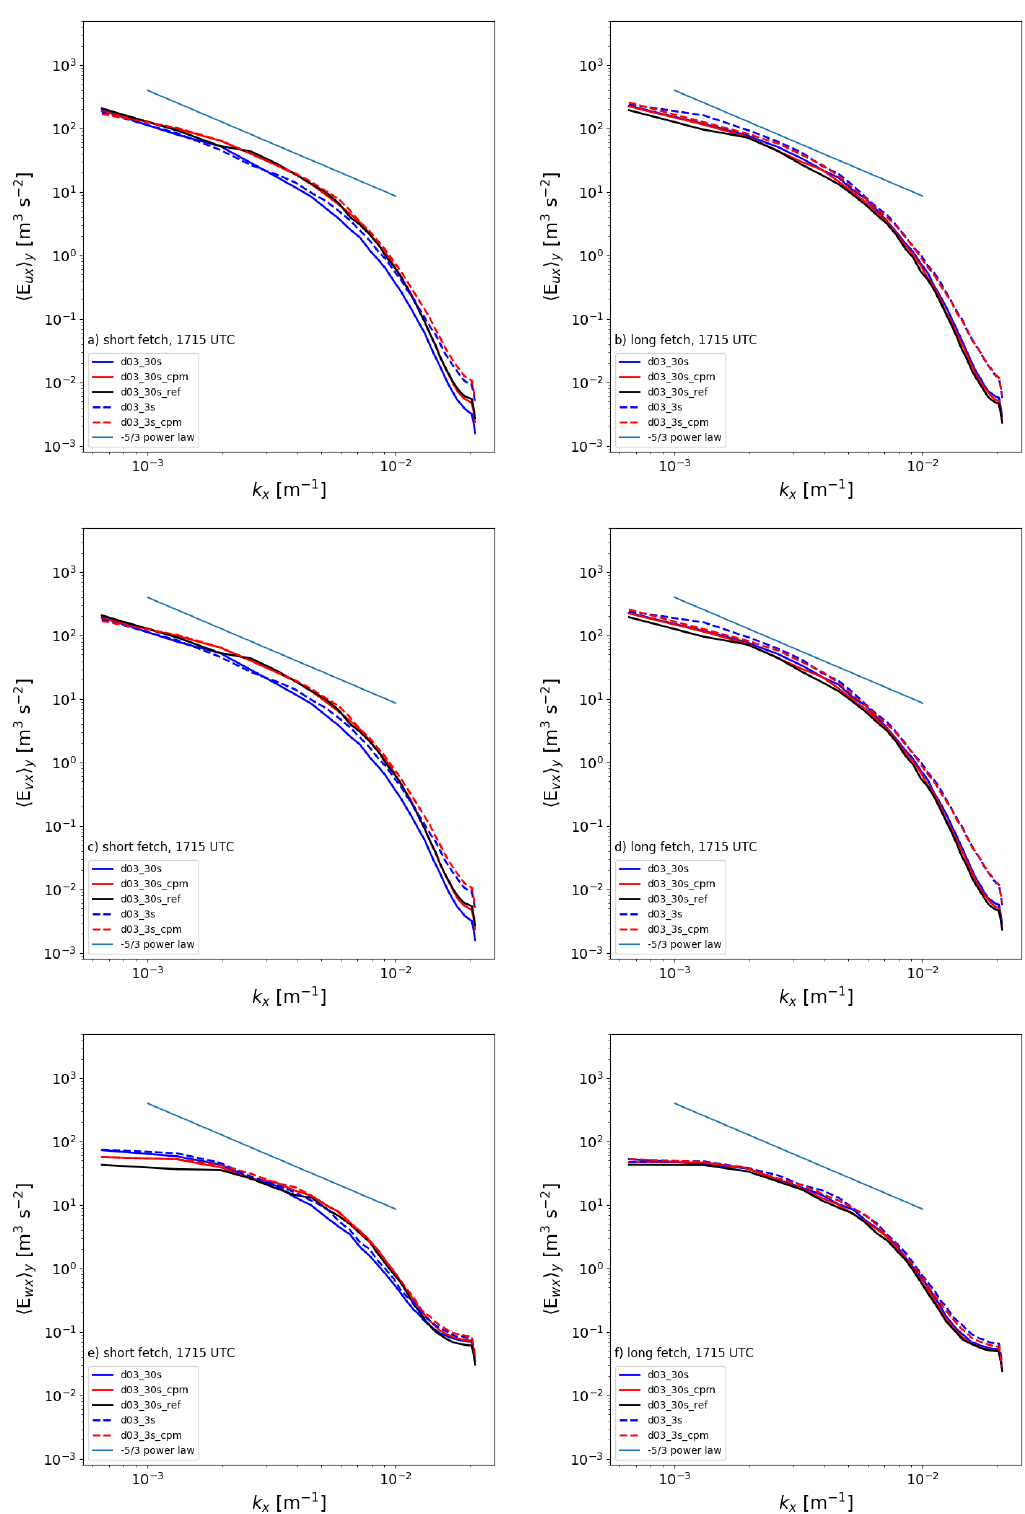
Figure 12. Spectral density of zonal ( a , b ), meridional ( c , d ), and vertical ( e , f ) velocity from subregions shown in Figure 9 after a minimum of 40 ( a , c , e ) points and of 120 ( b , d , f ) points of fetch from the smaller LES boundary and a minimum of 280 and of 360 points from the d03_30s_ref boundary. Model data are the average of 180 transects for each of 13 times from model output at 2.5 min intervals over the 30 min centered about the nominal time, 1715 UTC, roughly concurrent with the 1716 radiosonde release on 20 May